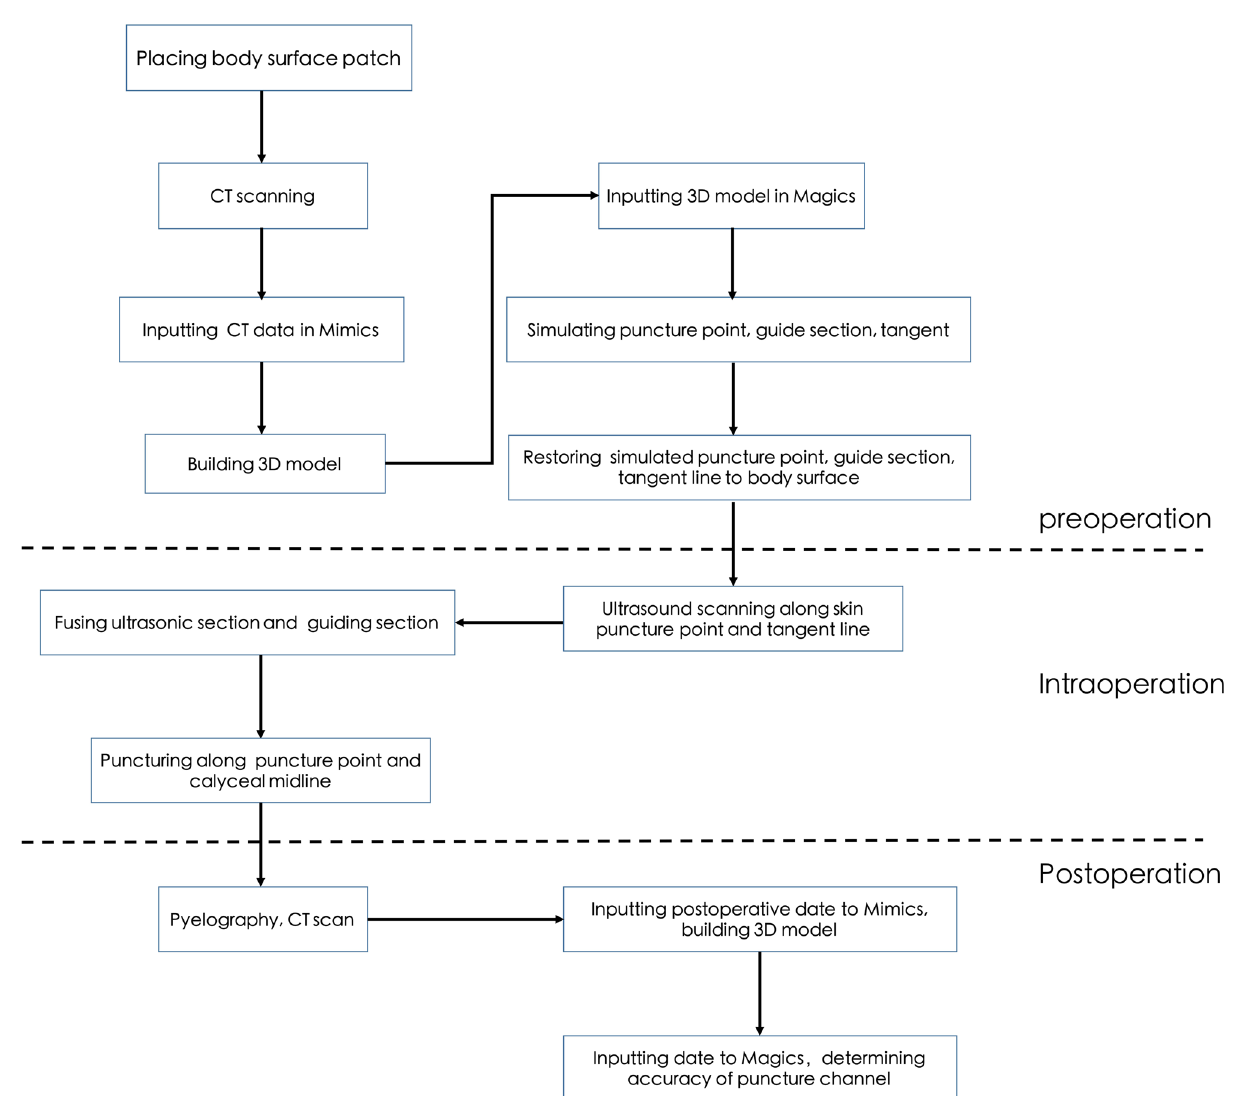
Figure 8. The technical flow chart of 3D visualization fused with